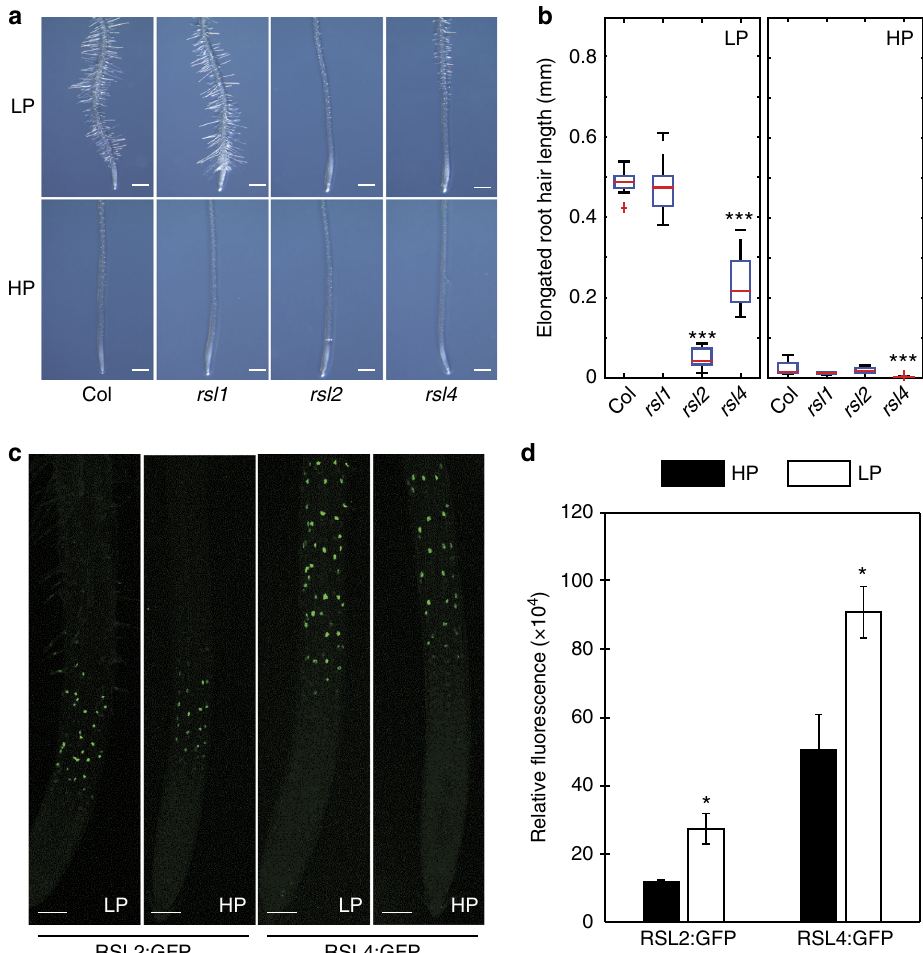
Fig. 5 bHLH transcription factors RSL2 and RSL4 are involved in low P responsive RH elongation in Arabidopsis . a , b Representative images ( a ) and boxplot ( b ) showing root hair growth of Columbia (Col), rsl1 , rsl2, and rsl4 mutant seedlings under low P (LP) or high P (HP) conditions. *, **, and *** indicate signi fi cant difference q -value < 0.005, 0.0001, and 0.00001, respectively, judged by Student ’ s t -test. N = 3, scale bar = 0.5 mm. c . Fluorescence intensity of pRSL2::GFP-RSL2 and pRSL4::GFP-RSL4 seedlings grown under low P (LP) and high P (HP). N = 3, scale bar = 100 µ m. d Measured raw integrated fl uorescence intensities of pRSL2::GFP-RSL2 and pRSL4::GFP-RSL4 grown for 5 days under low (LP, empty bars) and high (HP, black bars) P conditions. *Indicates signi fi cant difference ( q value < 0.05), judged by Student ’ s t